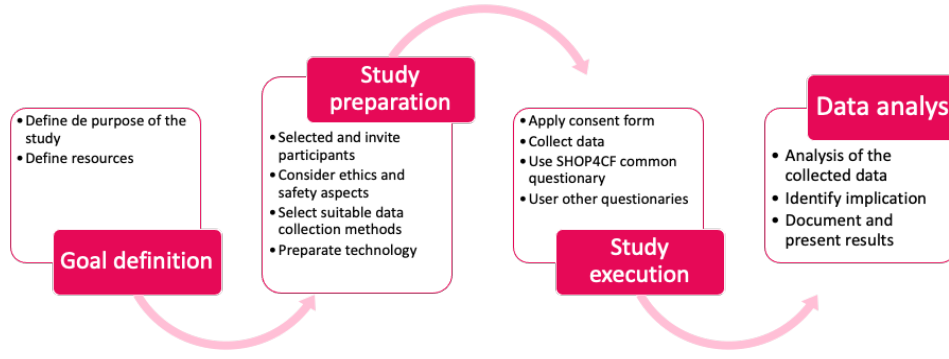
Figure 4. SHOP4CF evaluation framework.